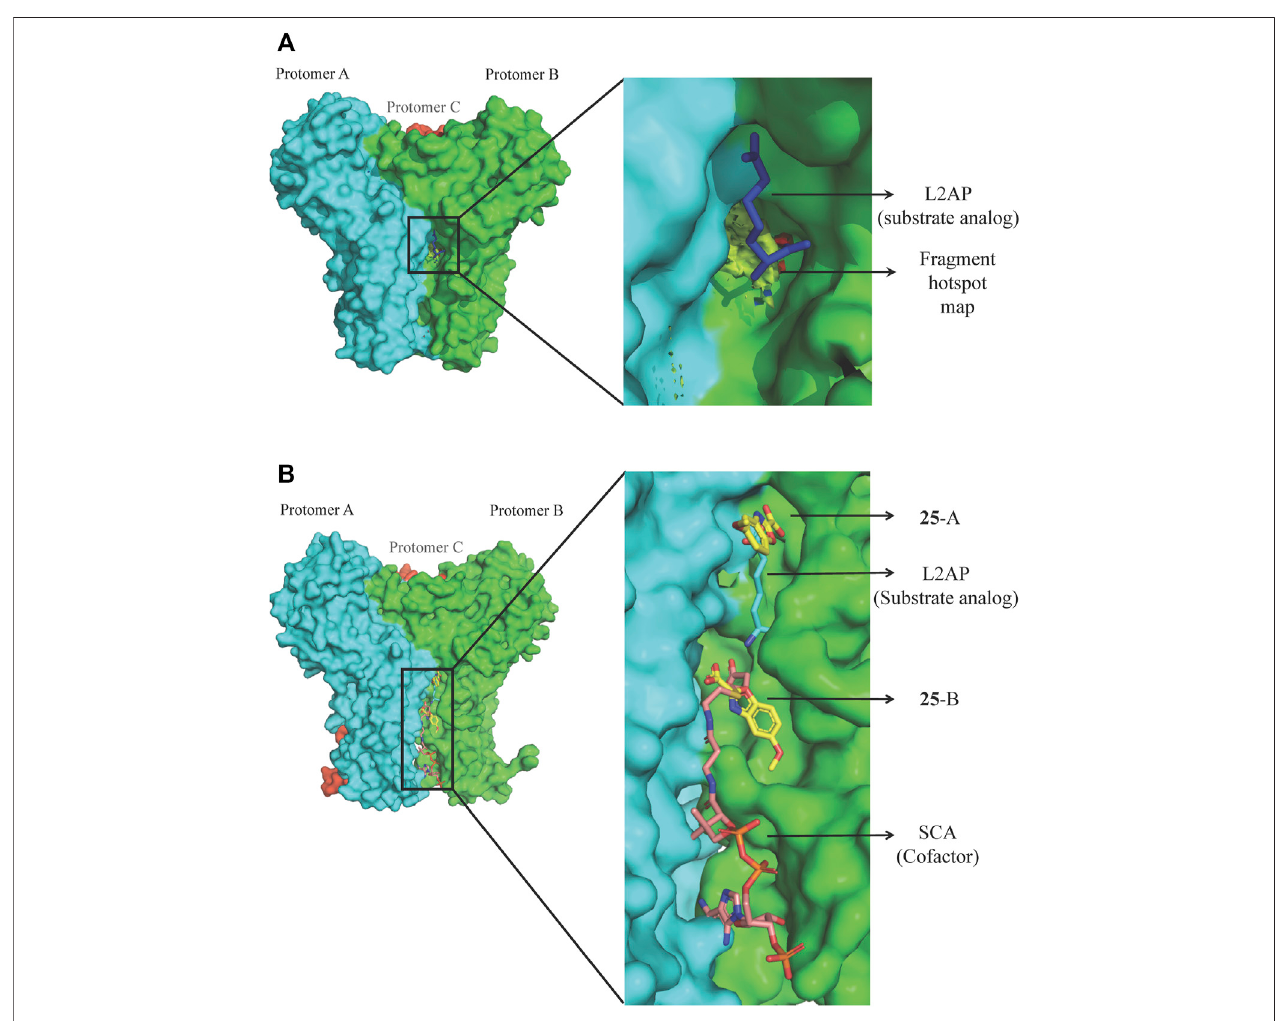
FIGURE 8 | FBDD against Pa DapD. (A) Binding site and fragment hotspot maps of Pa DapD. The yellow region in the zoomed view represents the hydrophobic map while hydrogen-bond acceptor and hydrogen-bond donors are represented in red and blue, respectively. (B) ligands from various Pa DapD-ligand complexes mapped on the structure of Pa DapD- 25 complex. 25 binds at two different sites in the protomer-protomer interfaces of Pa DapD. 25 at site A overlaps with the binding site of the substrate analog L2AP, while that at site B overlaps with the binding site of the cofactor SCA.